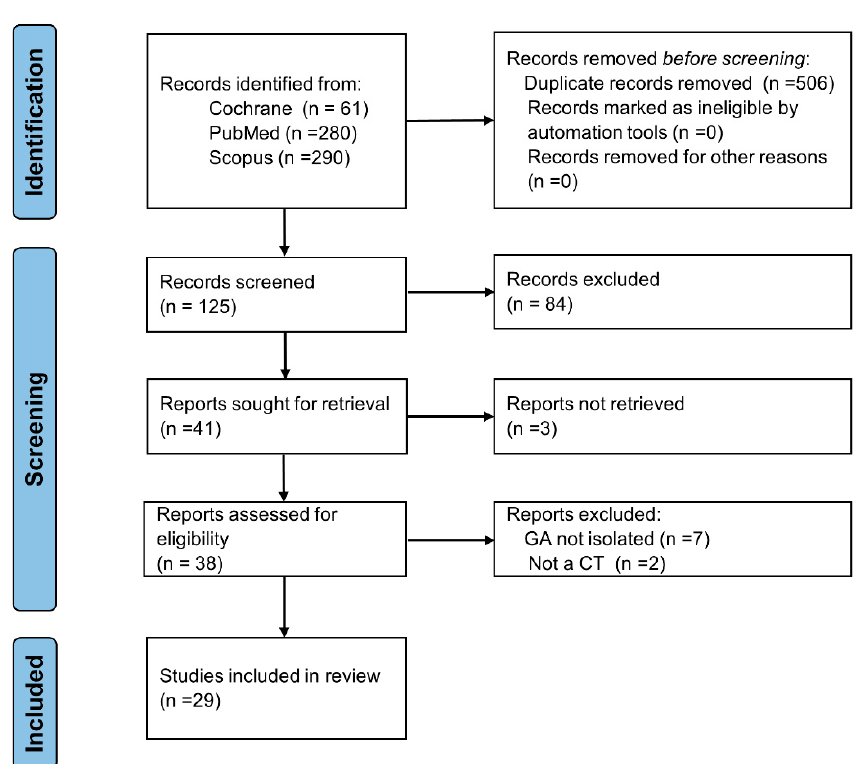
Figure 3. PRISMA flow diagram showing the selection, inclusion, and exclusion of clinical trial studies.